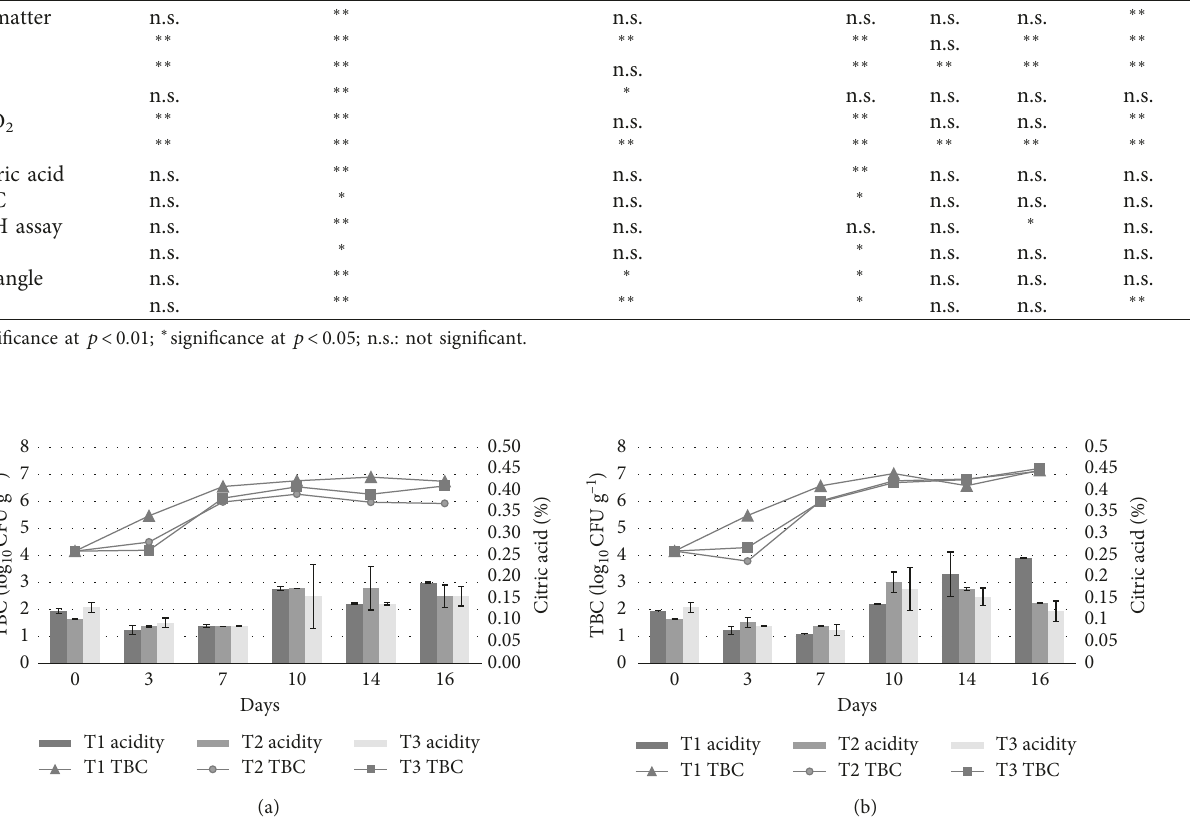
Figure 2: Effect of dark (a) and light (b) conditions on total bacteria count and titratable acidity of Valeriana pretreated leaves stored for sixteen days.